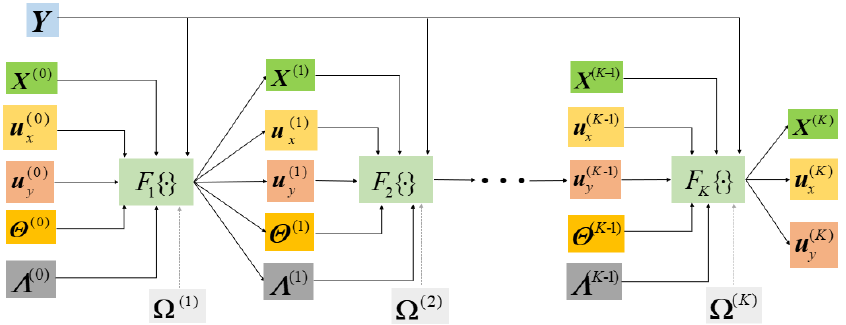
Figure 3. The network structure of DANM-ADMM-Net.